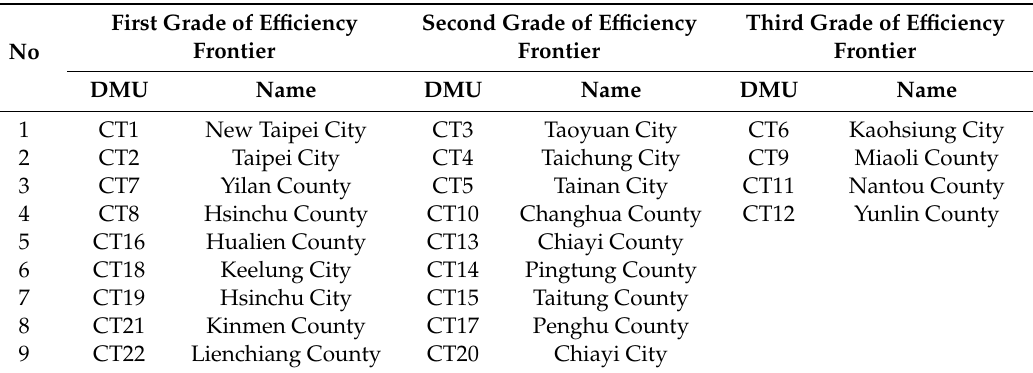
Table 6. Classification of e ffi ciency